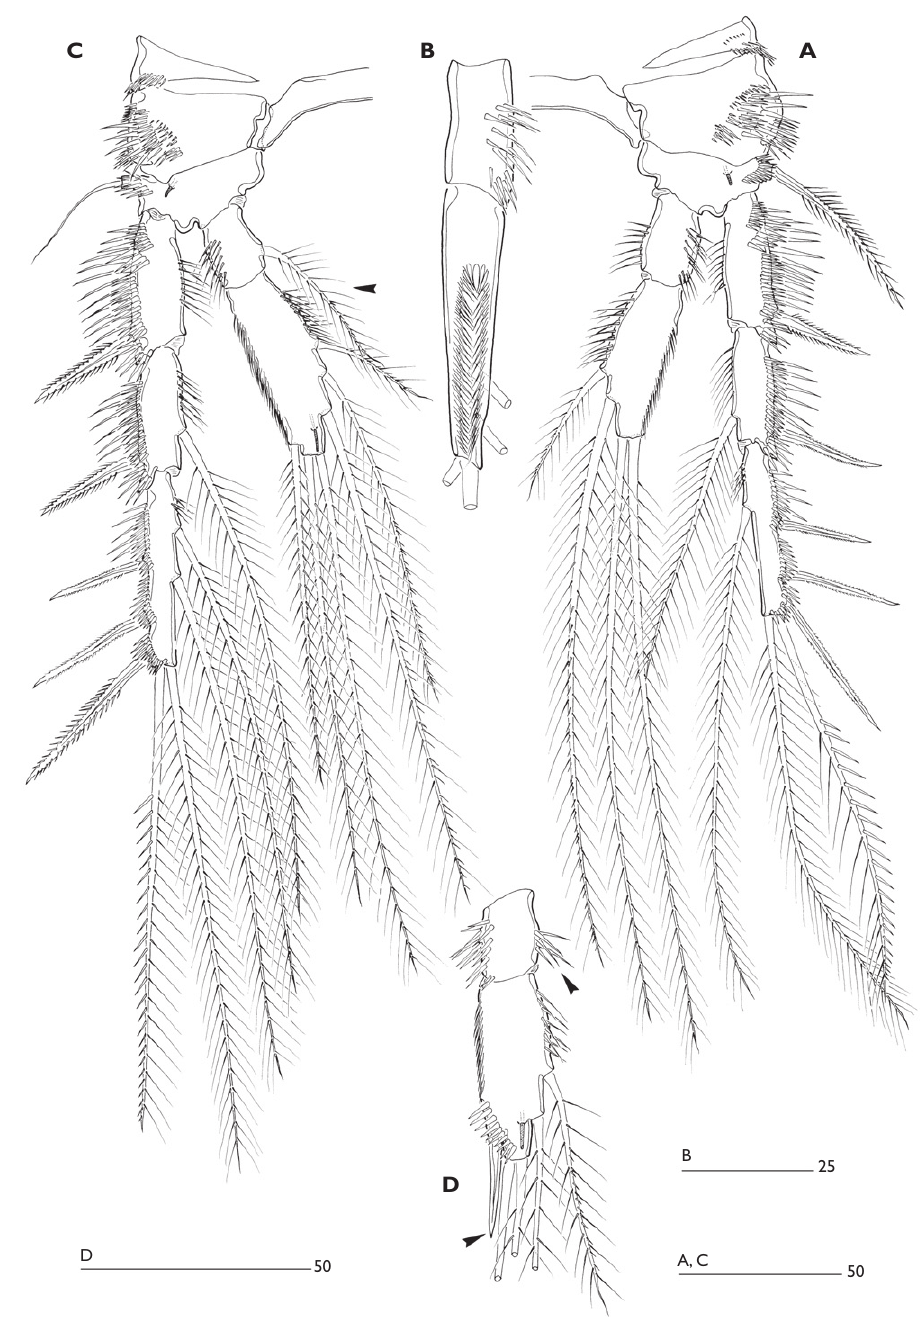
Figure 5. Marbefi a carthyi (Hamond, 1968), comb. n.: A P2 ♀ , anterior, B P2 endopod ♀ , outer lateral C P3 ♀ , anterior [inner seta on enp-1 arrowed] D P3 endopod ♂ [spinules on enp-1 and apophysis on enp-2